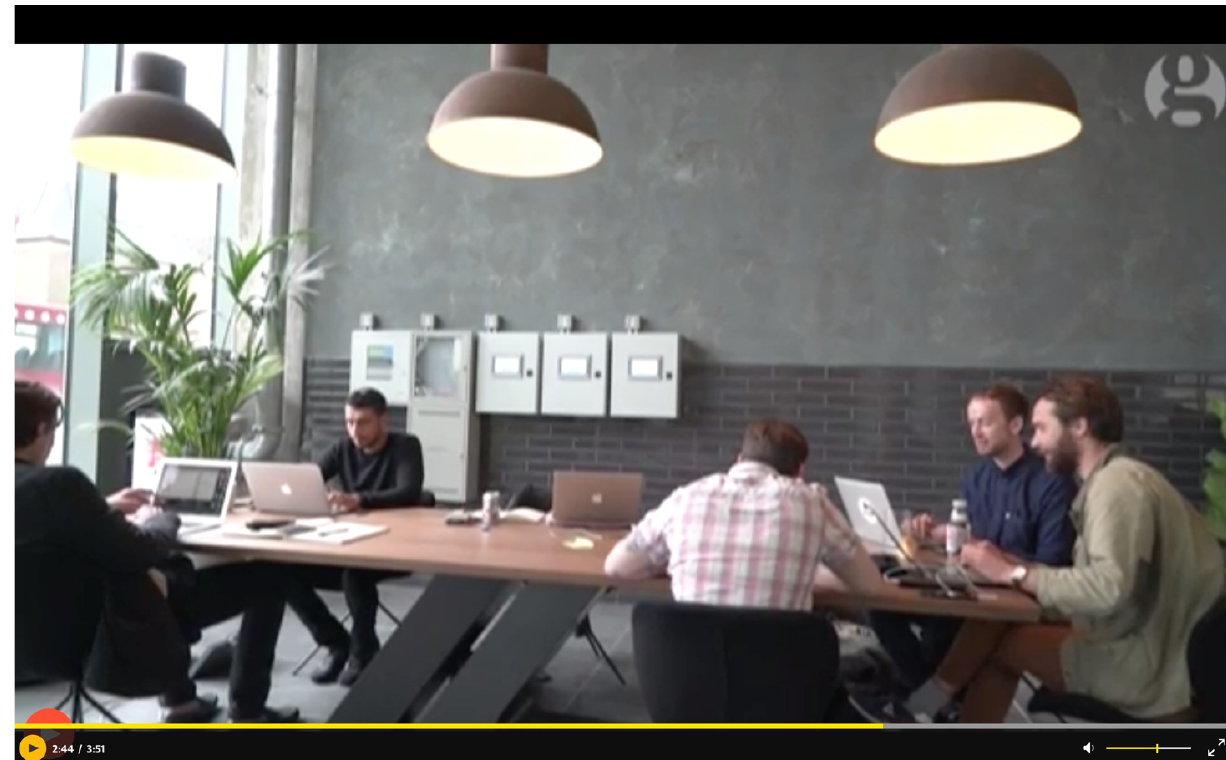
Figure 4. Co‐working space of the Collective in London. Source: Still frame from Coldwell